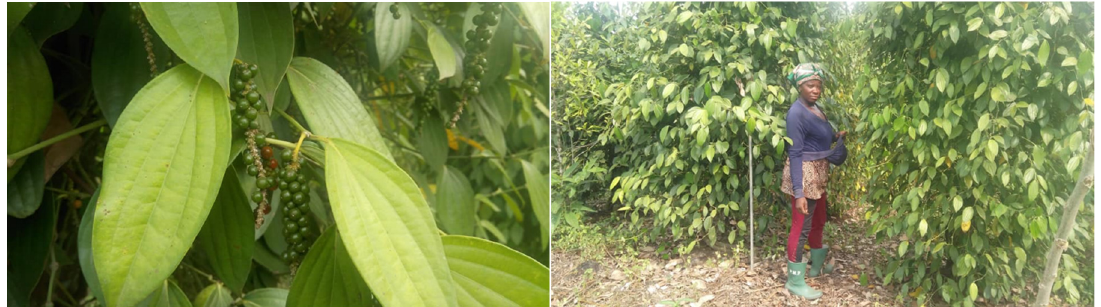
Figure 2. Harvesting pepper without any protective equipment and collecting in clothes (Njombe, Figure 2. Cameroon).